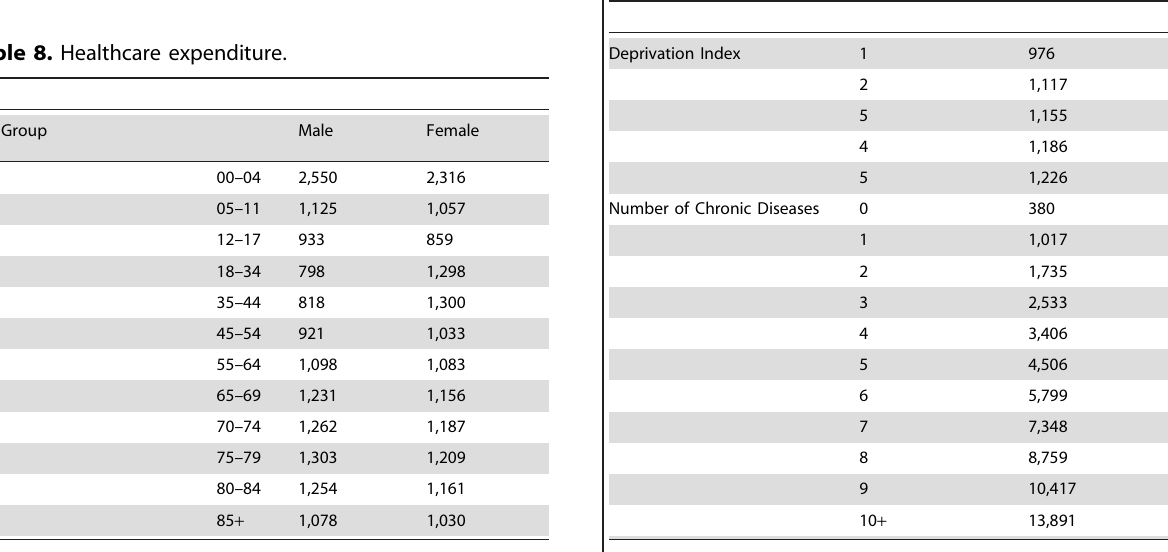
Table 9. Healthcare